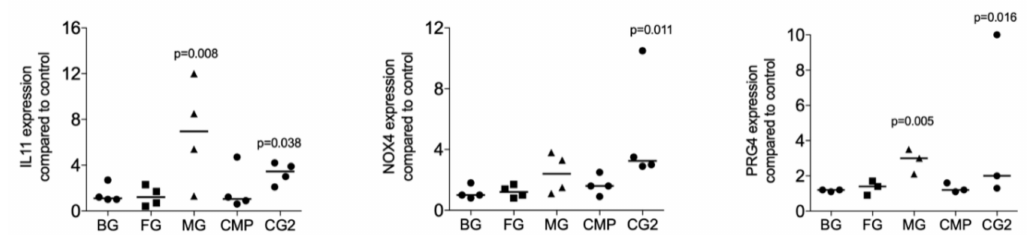
Lysates of Mucograft ® (MG) and Collagen Graft 2 (CG2) increase TGF- β target genes expression.